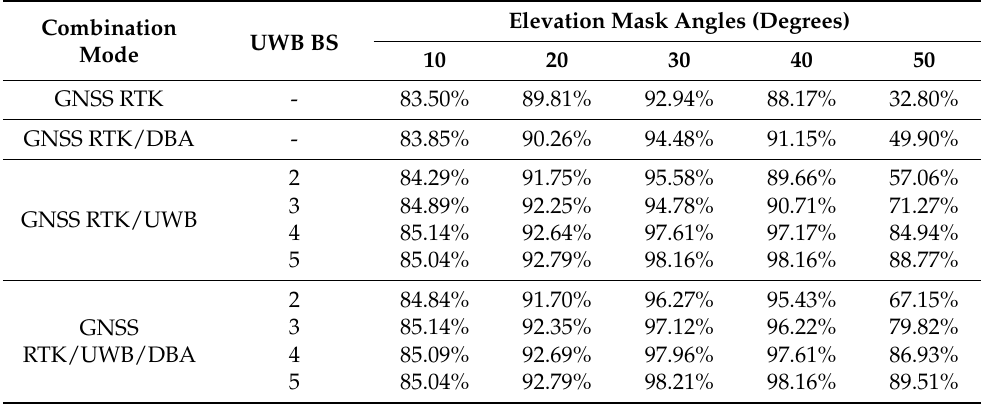
Figure 9. Sequence of the PDOP values of the GNSS RTK/UWB/DBA fusion positioning model at various elevation mask angles in the dynamic cart environment. The elevation mask angles were as follows: ( a ) 10 degrees; ( b ) 20 degrees; ( c ) 30 degrees; ( d ) 40 degrees; ( e ) 50 degrees. Table 7. The ambiguity resolution success rate of the GNSS RTK/UWB/DBA fusion positioning model at various elevation mask angles in the dynamic cart